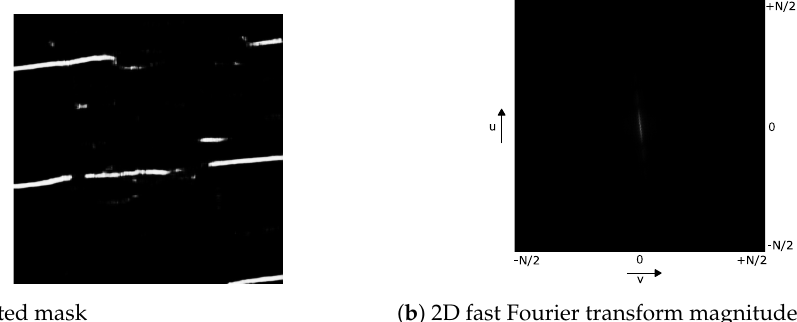
Figure 3. The 2D fast Fourier transform of the predicted segmentation mask in ( b ) shows a centered line whose orientation is orthogonal to the dominant orientation of the line segments in ( a ) the predicted segmentation